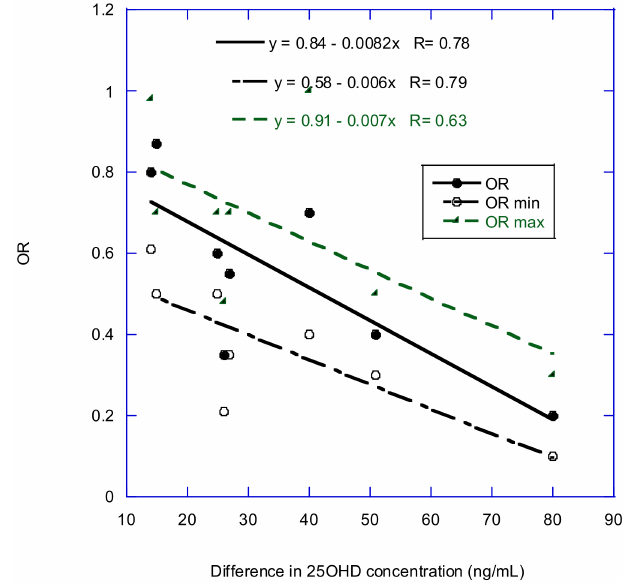
Figure 2. Plot of OR for cancer incidence versus the difference between minimum and maximum 25(OH)D concentration, using data from Table 7, omitting data for all cancer, breast cancer in McDonnell and colleagues [69], and data for prostate